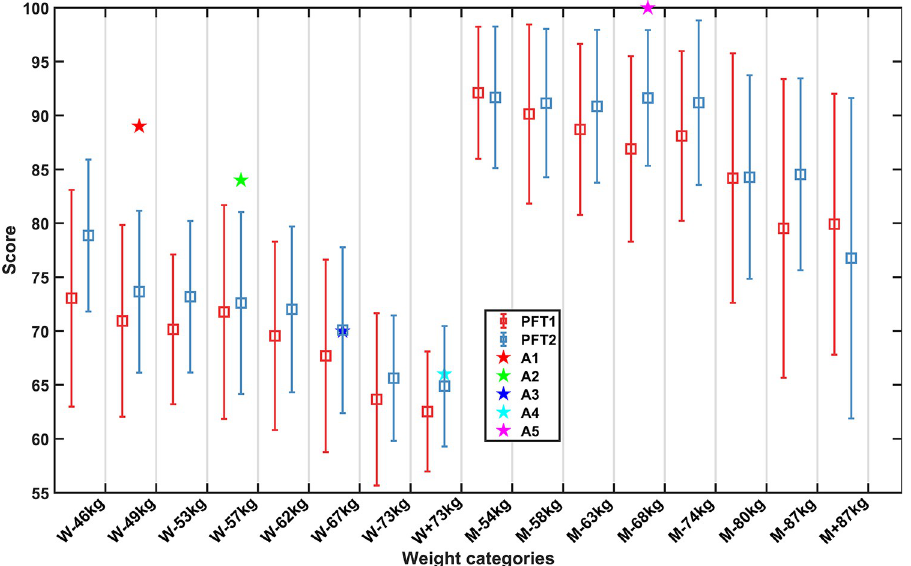
Fig 5. PFT scores of athletes in different weight categories. Mean value and standard deviation are represented by box and solid line respectively (p < 0.001). Scores of the national team athletes are marked by five-pointed stars.